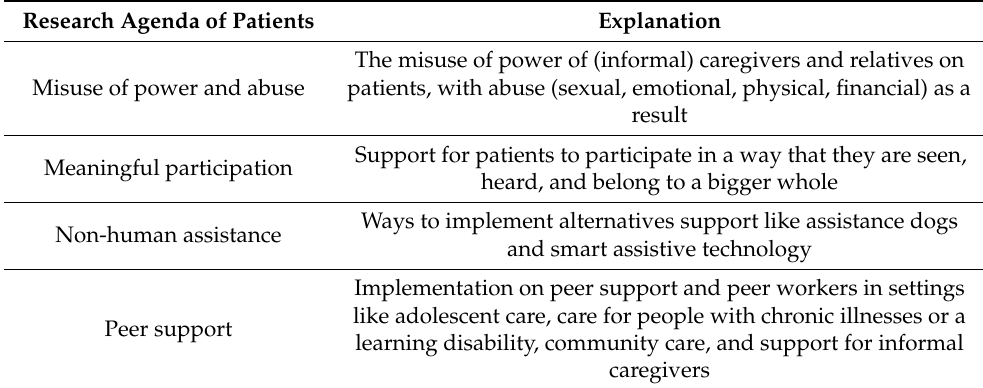
Table 2. The research agenda of patients based on 18